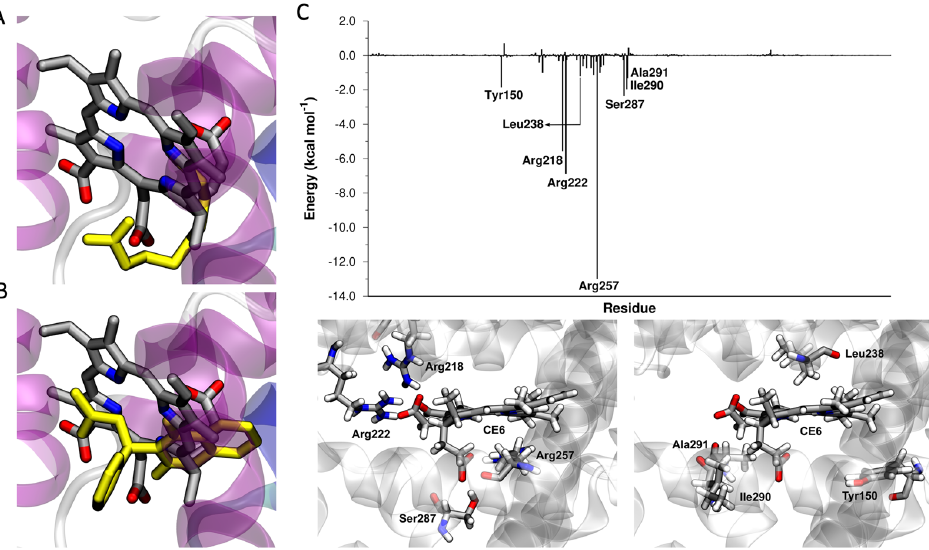
Figure 3. ( A ) A superposition of the crystallographic structure of myristic acid (in yellow, PDB:6YG9) and a docked structure of Ce6 in the Sudlow I site; ( B ) a superposition of the crystallographic structure of warfarin (in yellow, PDB:2BXD) and a docked structure of Ce6 in the Sudlow I site; ( C ) Ce6 − HSA interactions in the Sudlow I site. ∆ E binding decomposed per residue. A 3D representation of the most interacting